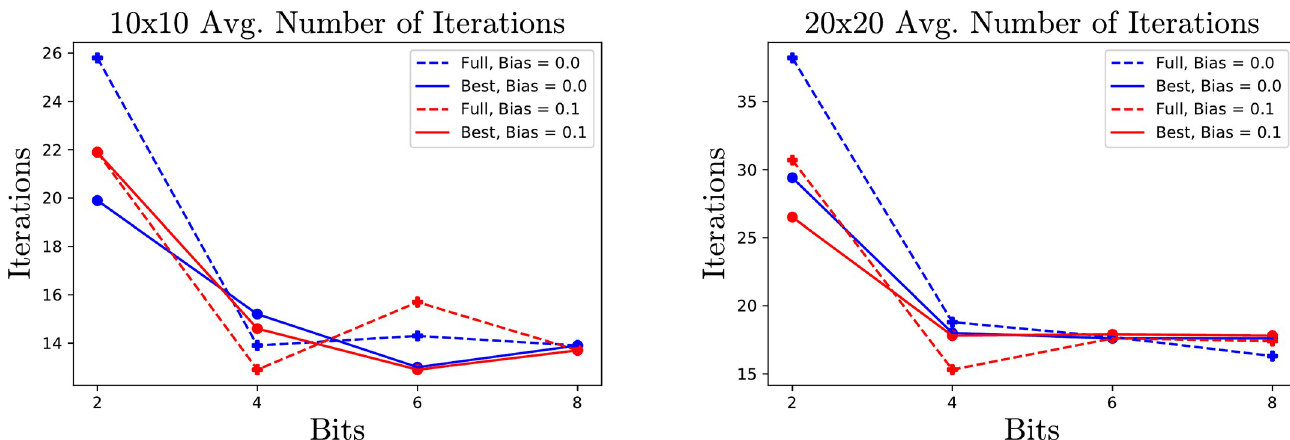
Fig 5. Average number of iterations required for MP matrices for different parameters.